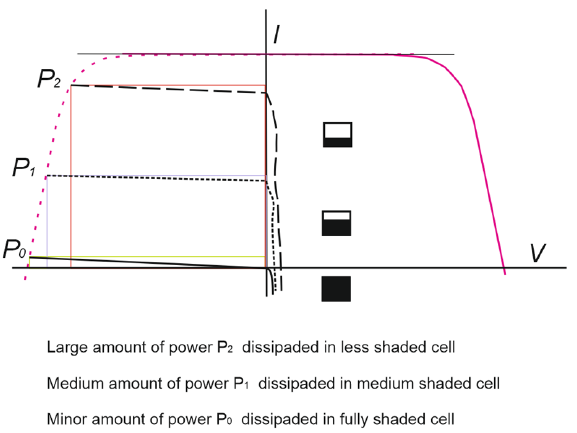
Figure 4. Power dissipation vs. shaded area size.